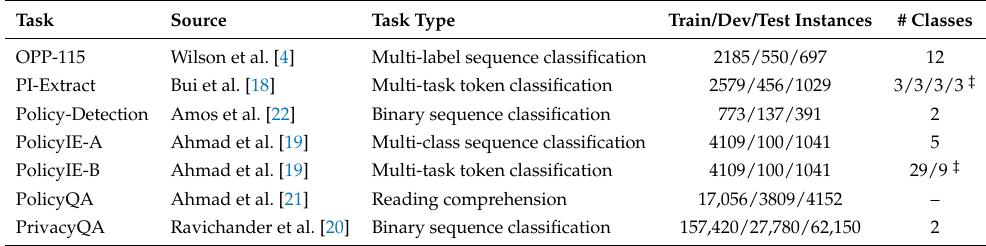
Table 1. Summary statistics of PrivacyGLUE benchmark tasks; ‡ PI-Extract and PolicyIE-B consist of four and two subtasks, respectively, and the number of BIO token classes per subtask are separated by a forward-slash